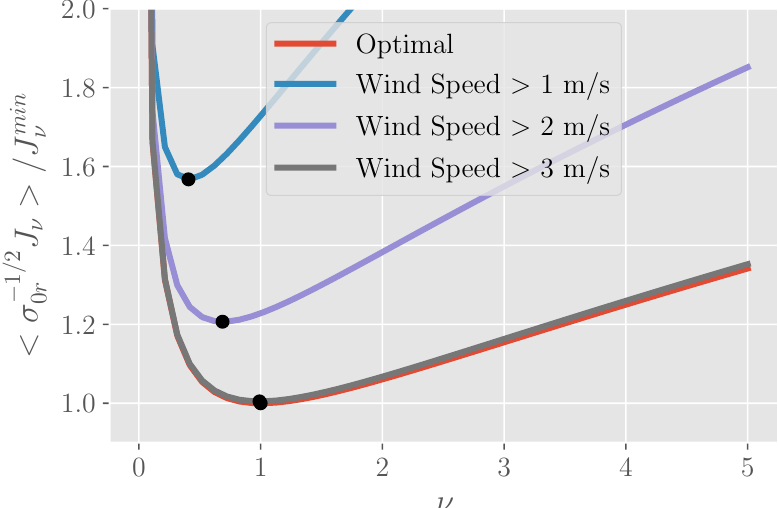
Figure 3. Ratio of σ − 1/2 r J ν to the minimum achievable value of J ν as a function of ν and for lower wind speed thresholds of 1m/s (aqua), 2m/s (magenta), and 3m/s (gray). In red is the optimal (cid:68) (cid:69) curve given in Equation (20). The location of the optimal ν is indicated by a circle. For Equation(20), the optimum ν = 1, but the optimum value becomes smaller when the wind speed distribution is accounted for, as in